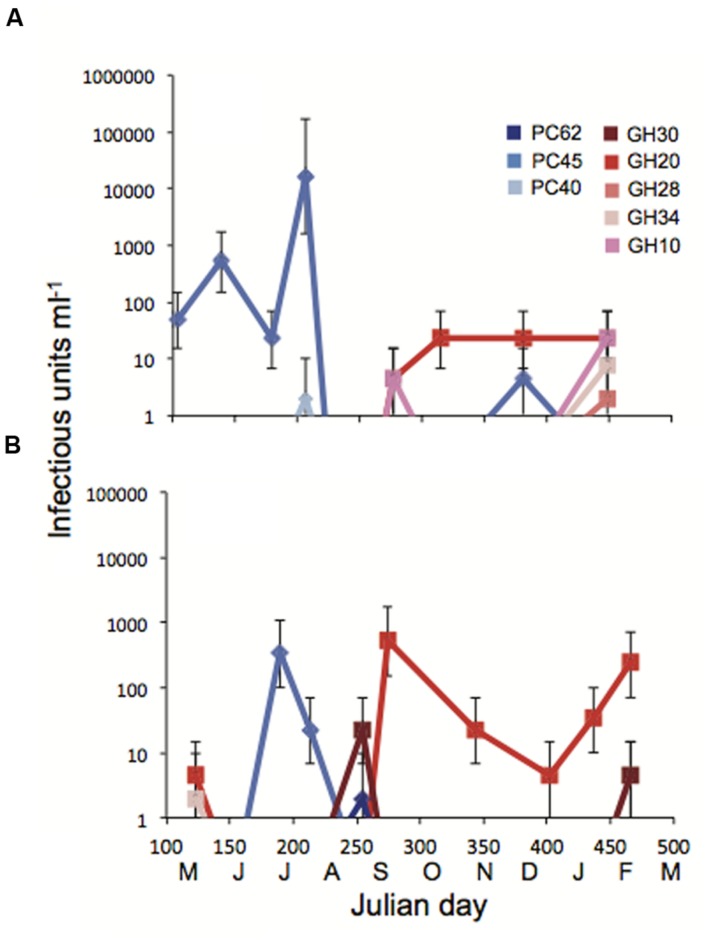
Titers of infectious units over time in Julian days with monthly increments at (A) Penn Cove and (B) Grays Harbor. Each of the nine strains was crossed with each of the Penn Cove or Grays Harbor viral communities. Cool colors are hosts isolated from Penn Cove, warm colors are hosts isolated from Grays Harbor. Error bars are 95% confidence intervals from 5 well MPN tables. Values below the limit of detection of 1.8 infectious units ml-1 are not shown.